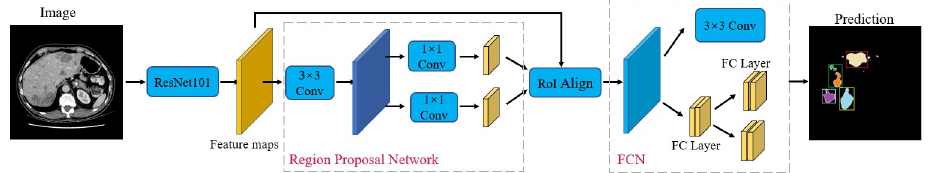
Fig 9. The detailed architecture of the